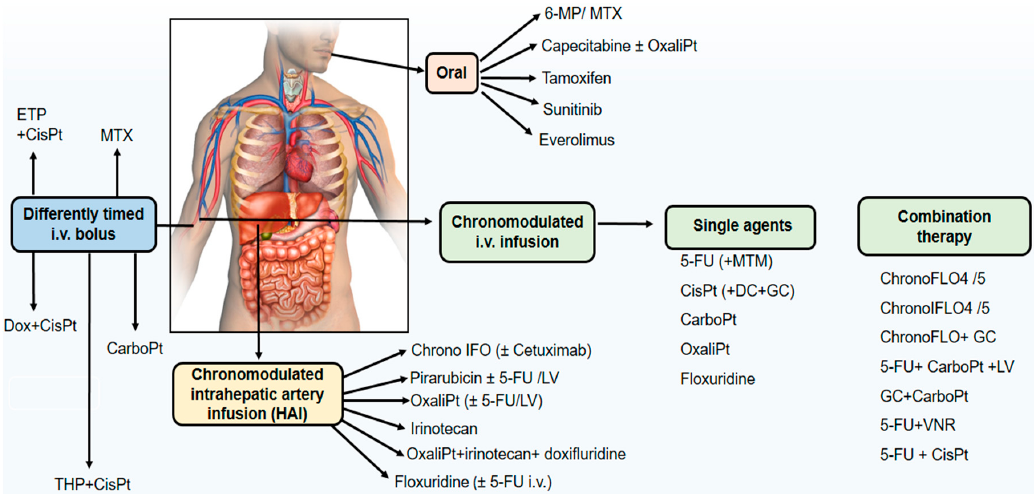
Figure 3. Administration route of cancer chronotherapeutics in phase II and III clinical trials. Anticancer drugs delivered by per oral, buccal, subcutaneous, intravenous (i.v.) and intrahepatic arterial (IHA) routes by using chronotherapeutic approaches. In i.v. administration routes, drugs are applied